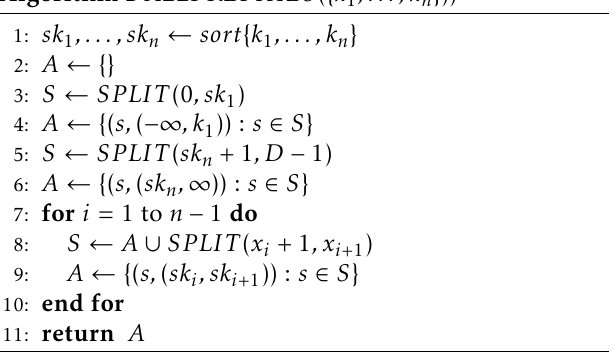
Figure 1. Interesting prefixes for {2,6,7,11} shown as the grey nodes } n